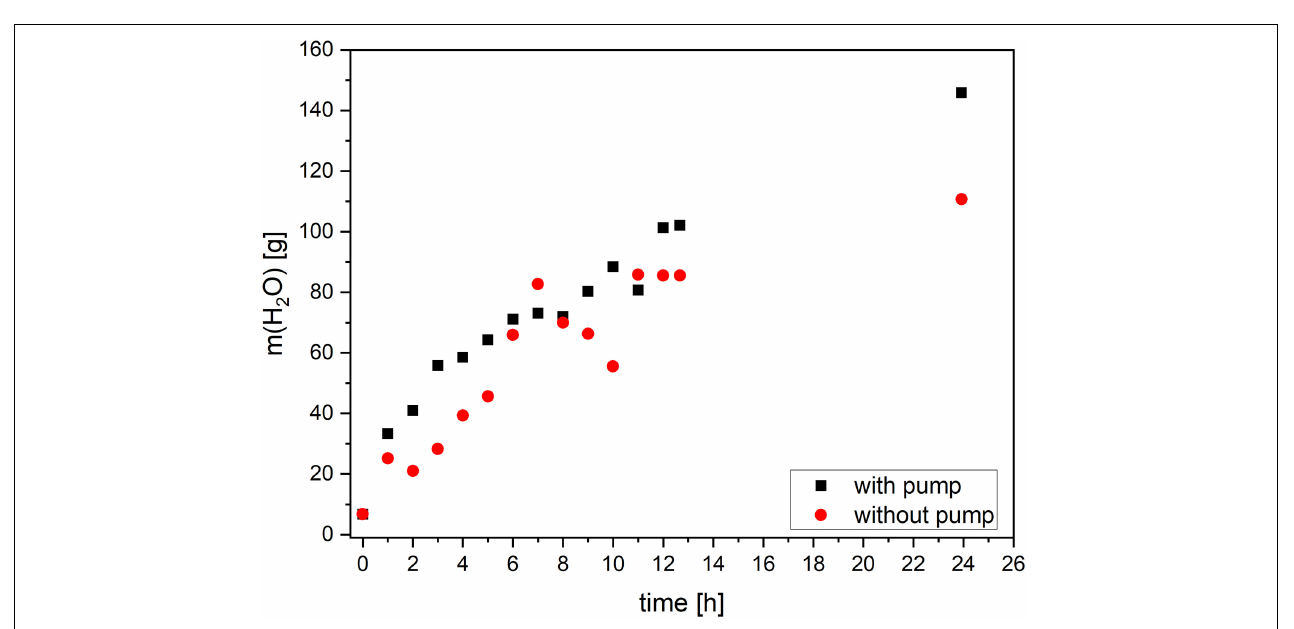
FIGURE 6 | Setup for dynamic solvent exchange with zeolites: (1) tube pump with adjustable speed; (2) container for samples, solvent, zeolites with a lockable window (marked with red circle) as a sampling point; (3) steel plate for sample placing ant transport; (4) lockable perforated box for zeolites. During solvent exchange the perforated box (4) filled with zeolite is placed on the bottom of container (2), on the top of the box is placed the plate (3) with wet gels. The direction of circulation of solvent is marked with red arrows.